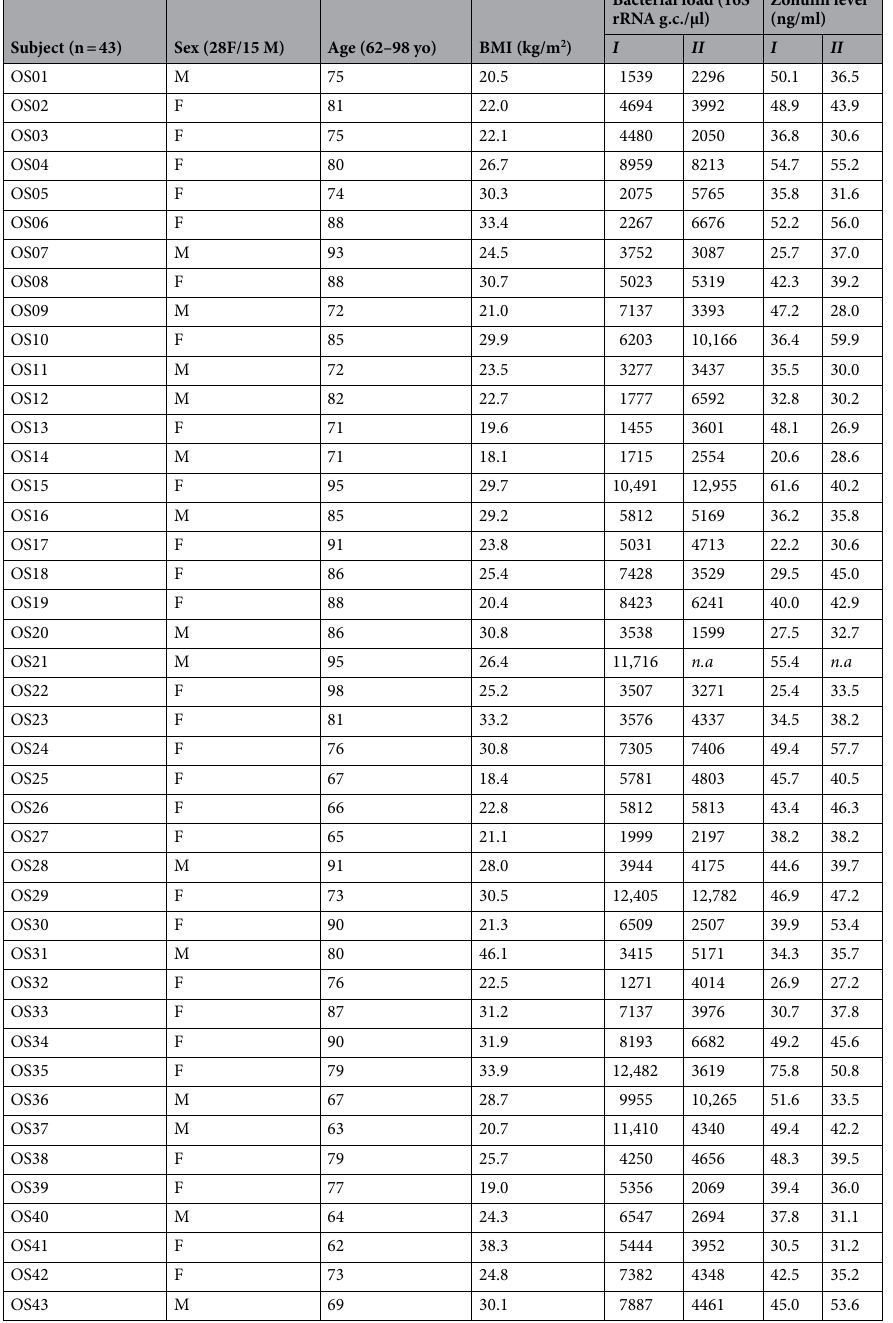
Table 1. Demographic and anthropometrical characteristics of older volunteers recruited for the study. Blood bacterial load (determined by qPCR and expressed as 16S rRNA gene copies per μl) and zonulin level (determined by ELISA test) are also shown. OS01-43, consecutive anonymized coding of the older subjects included in the study. 16S rRNA g.c., 16S rRNA gene copies; I and II , first and second set of blood samples analyzed, respectively; n.a. , data not available due to missing